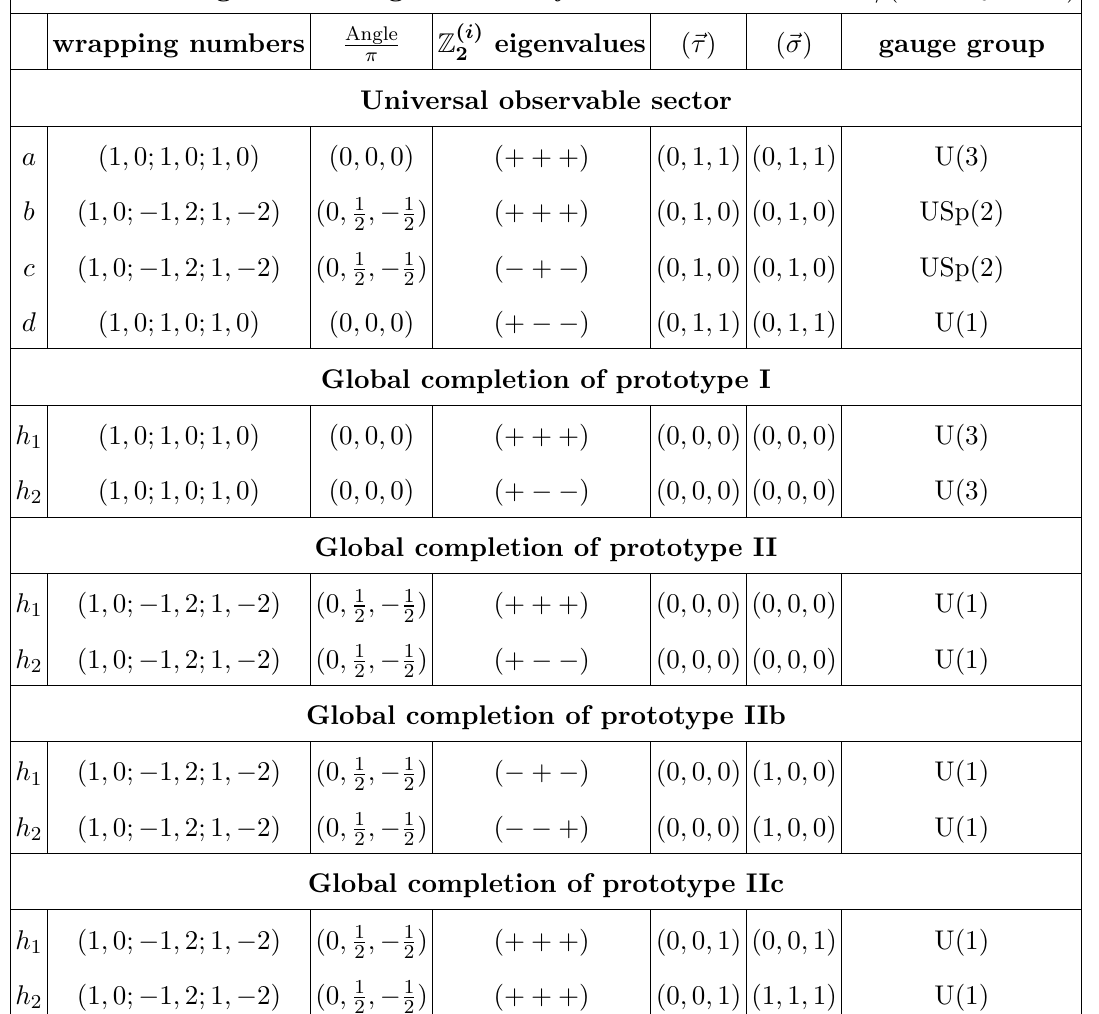
Table 18 . Local observable L-R symmetric D6-brane sector in the (cid:12)rst block with four di(cid:11)erent global completions by two ‘hidden’ branes h 1 , h 2 listed below. Observe that for prototype IIb, we have (+++) and (+ (cid:0)(cid:0) ) , and thus the only di(cid:11)erence w.r.t. prototype II is the di(cid:11)erent h 0 1 h 0 2